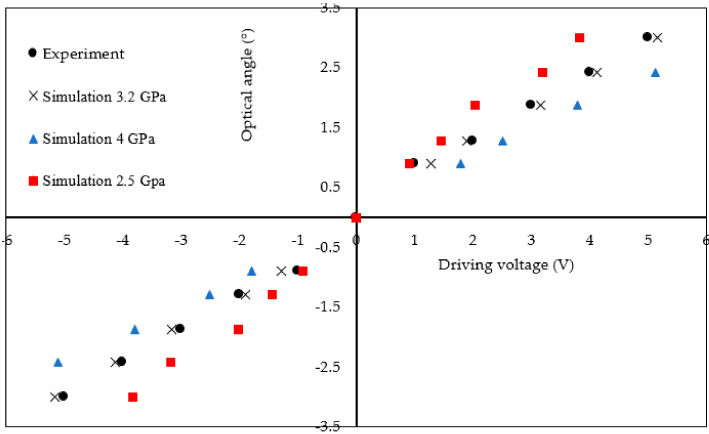
Figure 5. Simulated and tested static performance of the FPCB